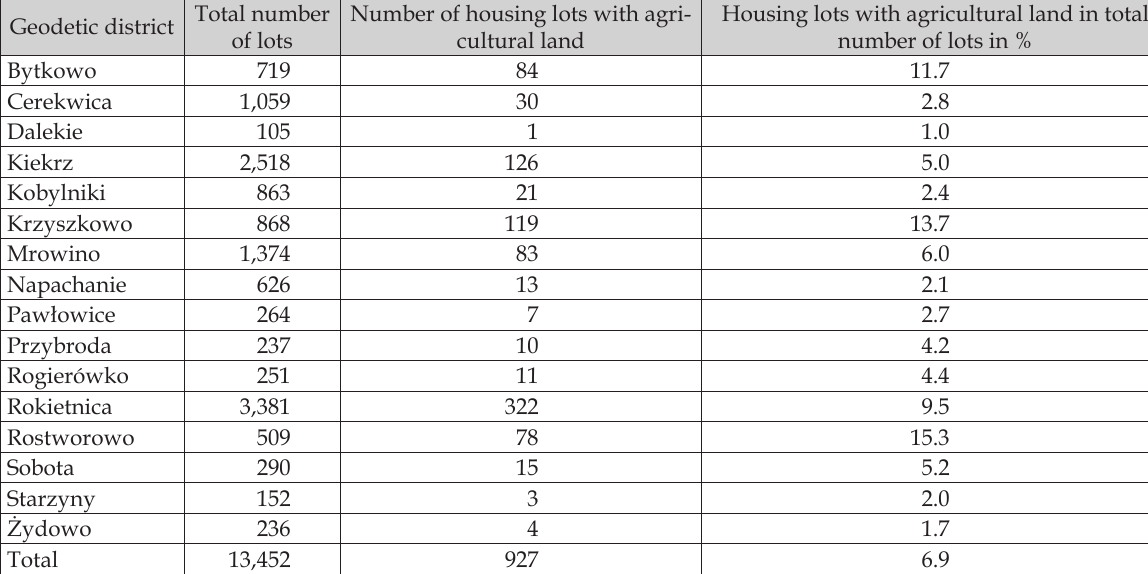
Table 3. Proportion of built-up housing lots with agricultural land in the total number of lots in Rokietnica commune, 2014.